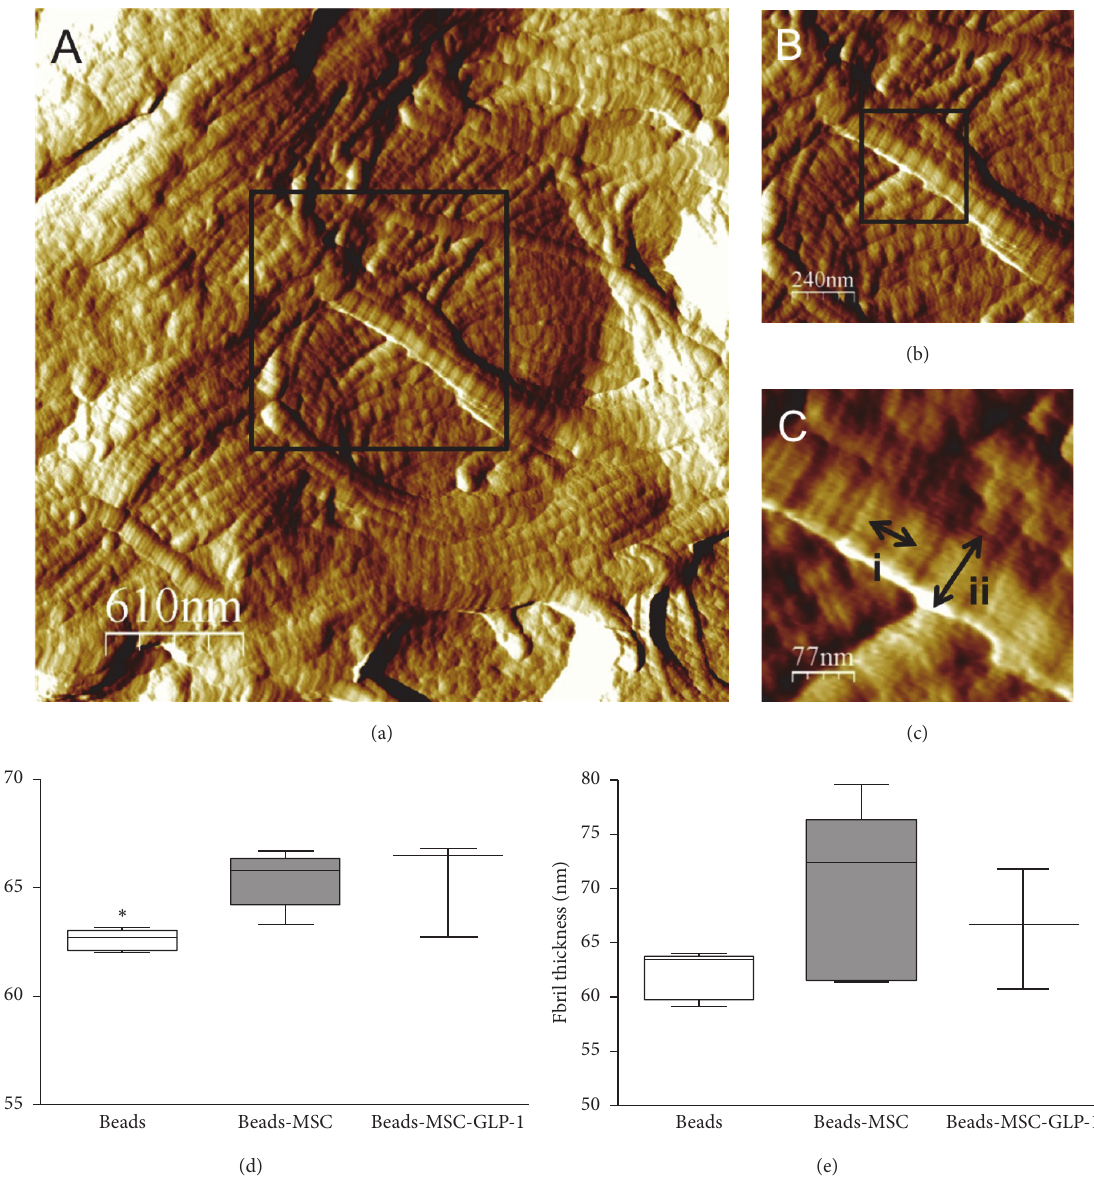
Figure 6: Collagen fibril structures identified using AFM. (a) Fibre bundles from an untreated scar four weeks following MI. (b) A higher magnification of micrograph (a) reveals more details of the individual fibrils comprising the bundle, with D-periods clearly visible. (c) D- period length (i) and fibril width (ii) are indicated by arrows. There were a significantly increased periodicity (d), 𝑃 < 0.05 , and a trend towards increased fibril thickness (e) in MSC treated groups four weeks after